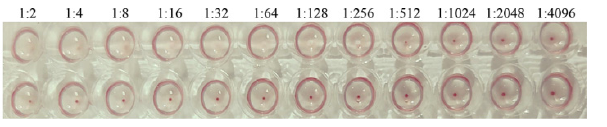
Table 1. Optimal sample dilutions and coating antigen for PPV-VLP-ELISA. Serum Di-